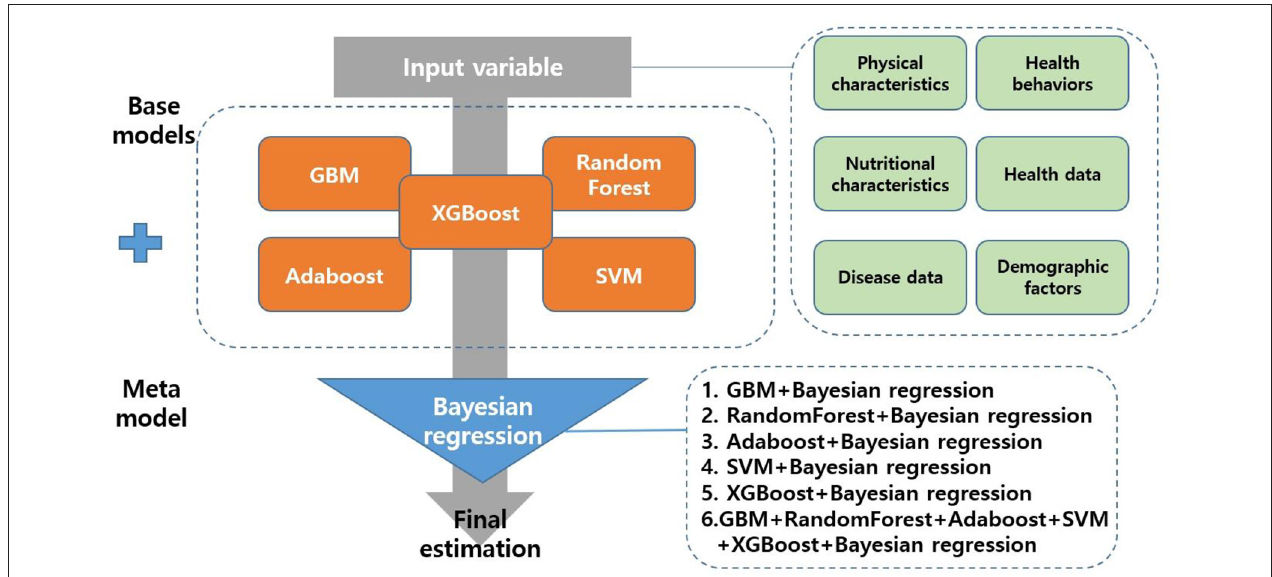
FIGURE 2 | Process flow diagram for depressive disorders of female older adults living alone.